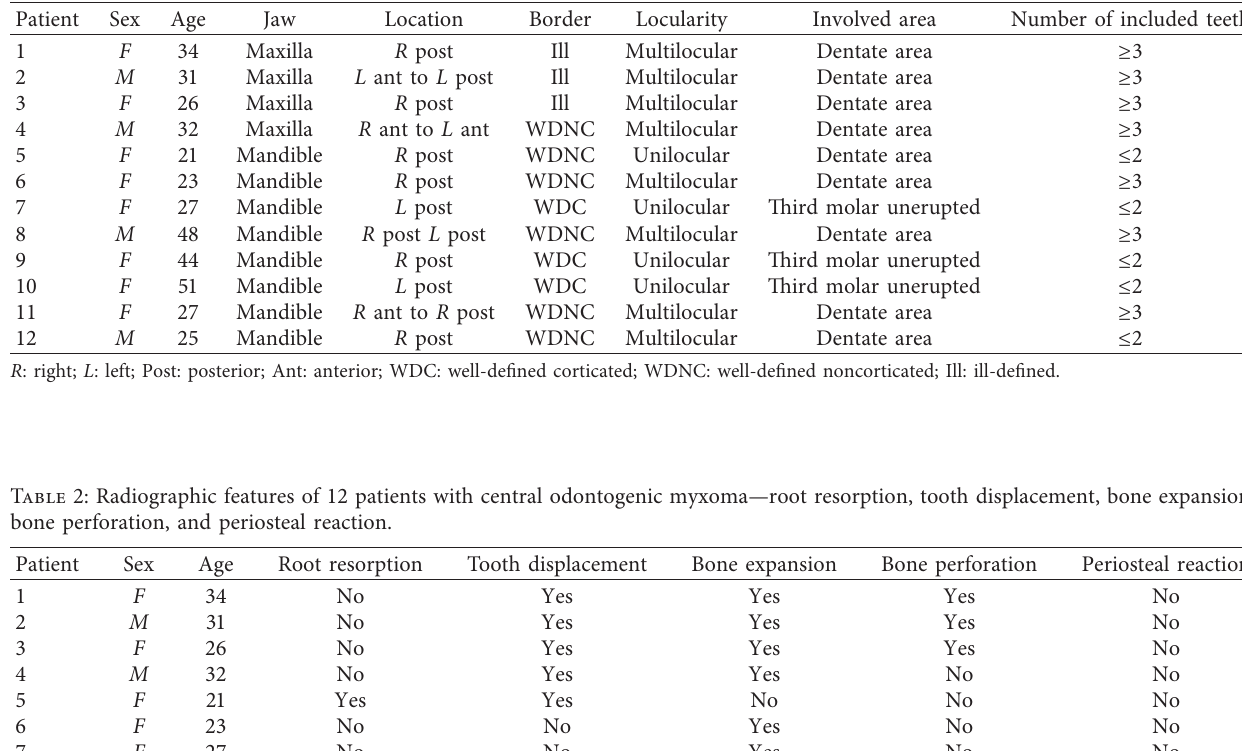
Table 1: Radiographic features of 12 patients with central odontogenic myxoma—location, border, locularity, involved area, and the number of included teeth.